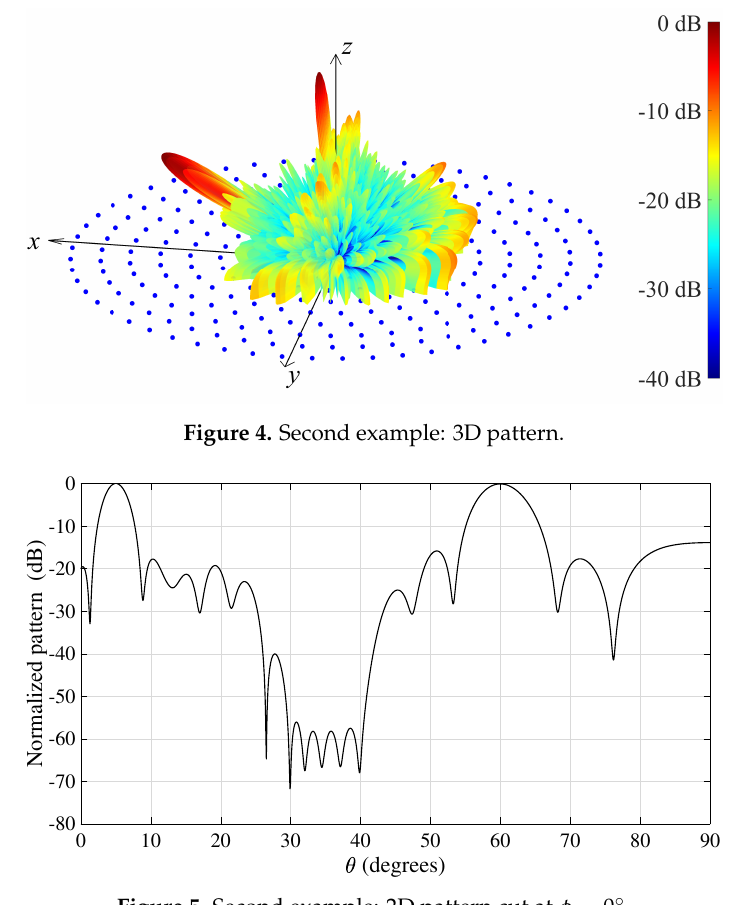
Figure 5. Second example: 2D pattern cut at φ = 0 ◦